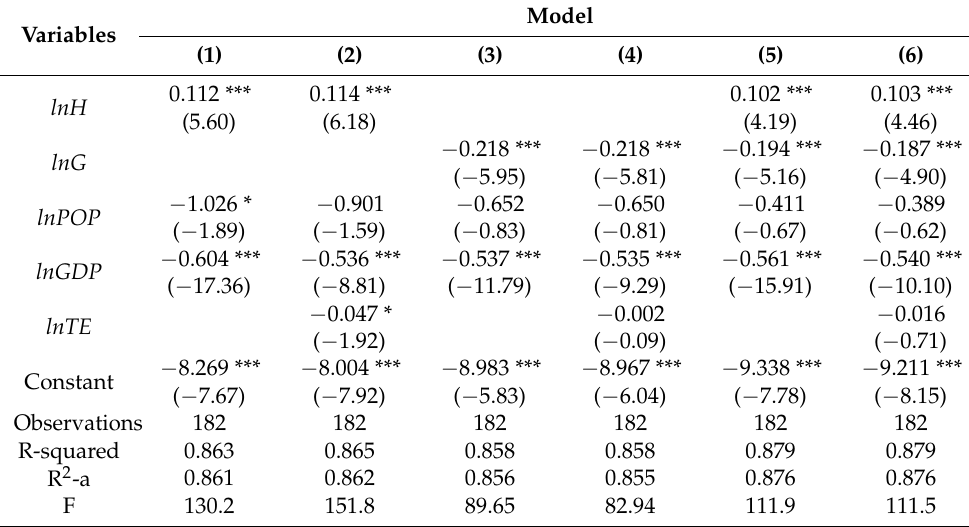
Table 6. Regression results analysis (robust